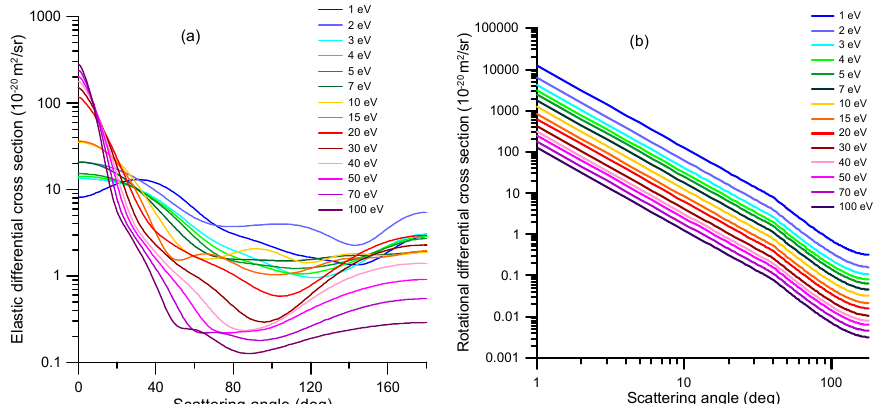
Figure 6. ( a ) Elastic differential cross sections, calculated with our R-matrix (1–15 eV) and IAM-SCAR (20–100 eV) methods, which are used to derive the normalized angular distribution functions for the elastic scattering processes. ( b ) Calculated dipole-Born differential cross sections used to derive the corresponding angular distribution functions for rotational excitation processes.